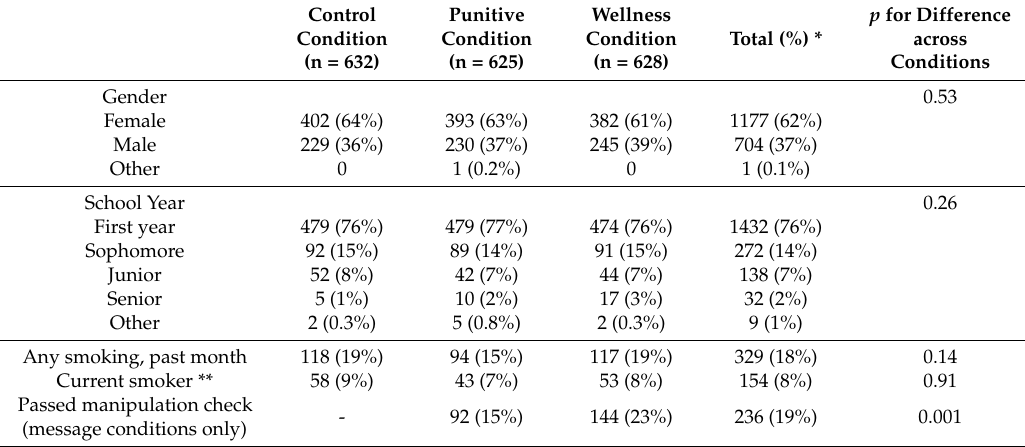
Table 1. Study participants, college students (n = 1885), spring 2016.